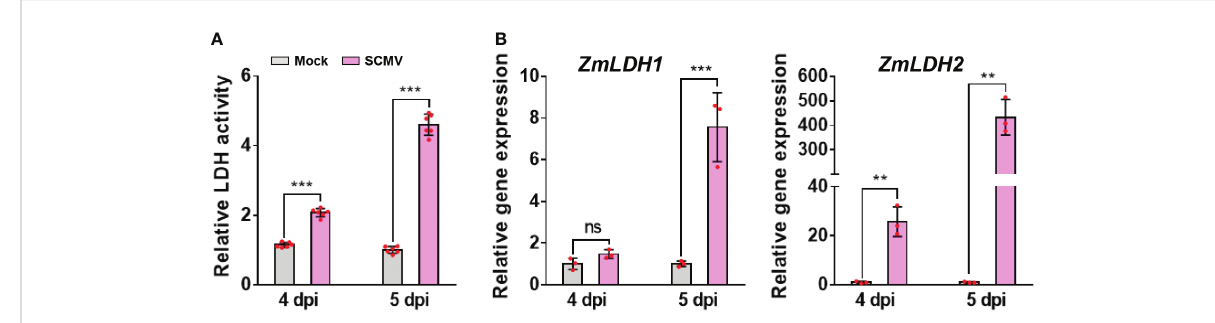
FIGURE 3 SCMV infection up-regulates LDH activity and genes expression. (A) Analysis of LDH enzyme activities in 1 SLs of mock-inoculated or SCMV-infected plants at 4 and 5 dpi. The results are represented as the means ± SE (n=6). (B) Relative transcriptional expression levels of ZmLDH1 and ZmLDH2 determined by RT-qPCR using mock-inoculated or SCMV-infected leaves harvested at 4 and 5 dpi. The data are represented as the means ± SE (n=3). Statistical differences were determined using unpaired Student ’ s t -test (two-tailed), ns, no signi fi cance; ** P < 0.01; *** P <